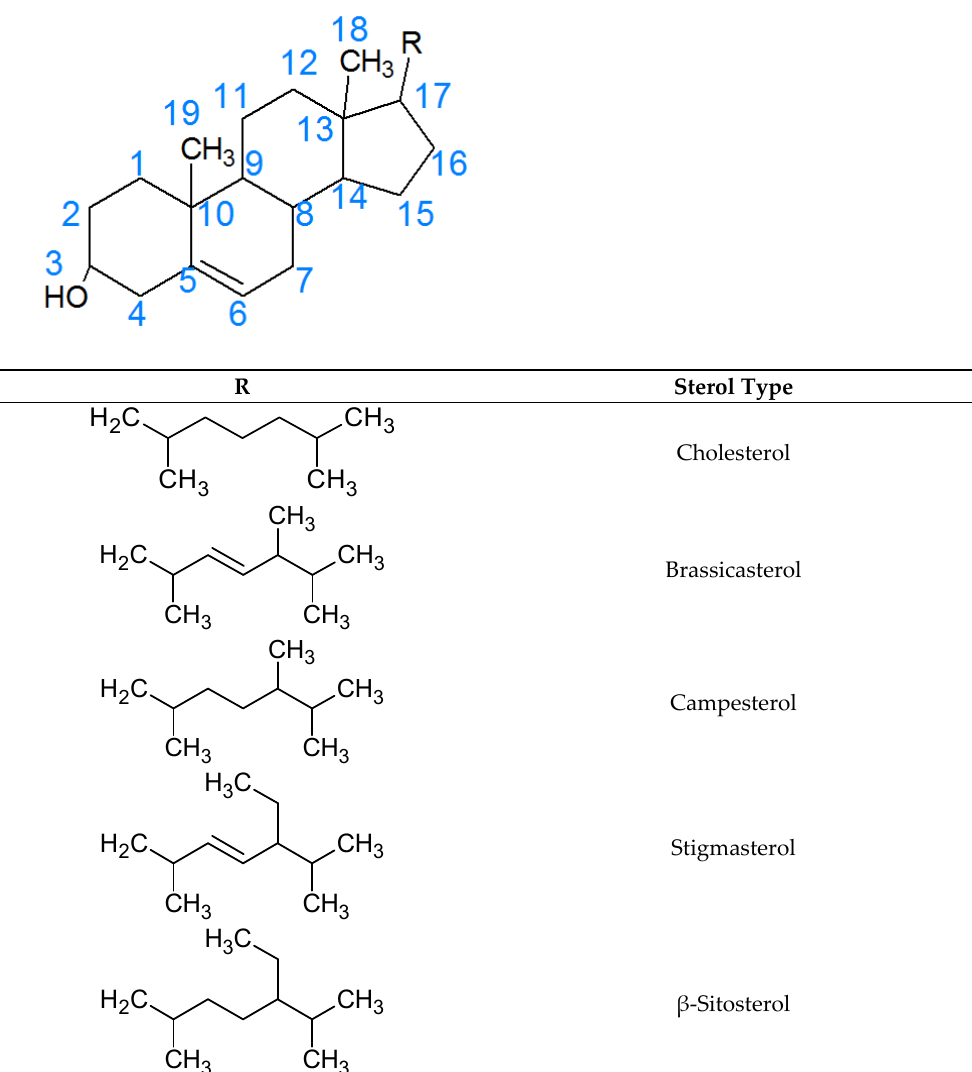
Figure 1. Nomenclature and structure of four abundant natural phytosterols (brassicasterol, campesterol, stigmasterol, and β -sitosterol), including cholesterol.